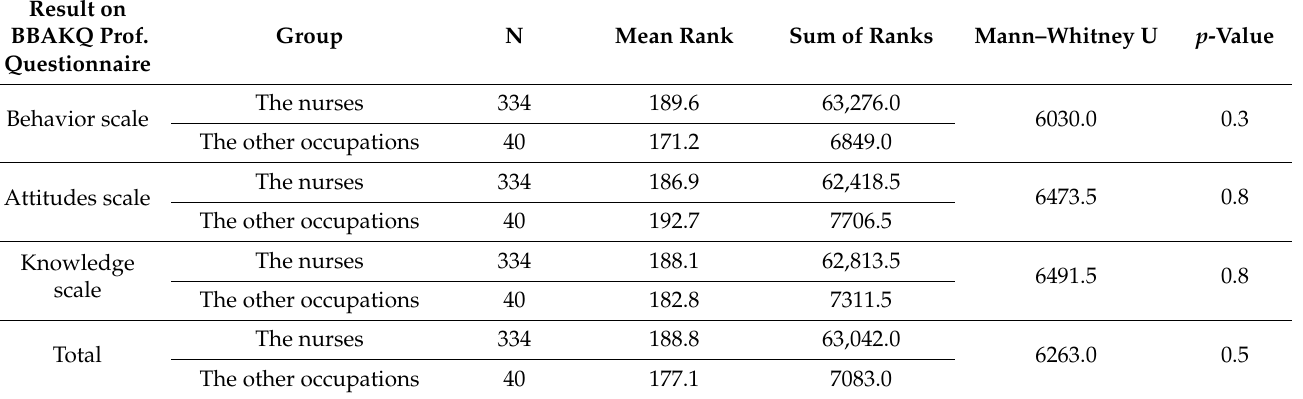
Table 4. Overview of the results of the Mann–Whitney U Test for the results of respondents on the scales of behavior, attitudes, and knowledge and the overall respondents’ results in relation to occupation (nurse/other occupations) (N =